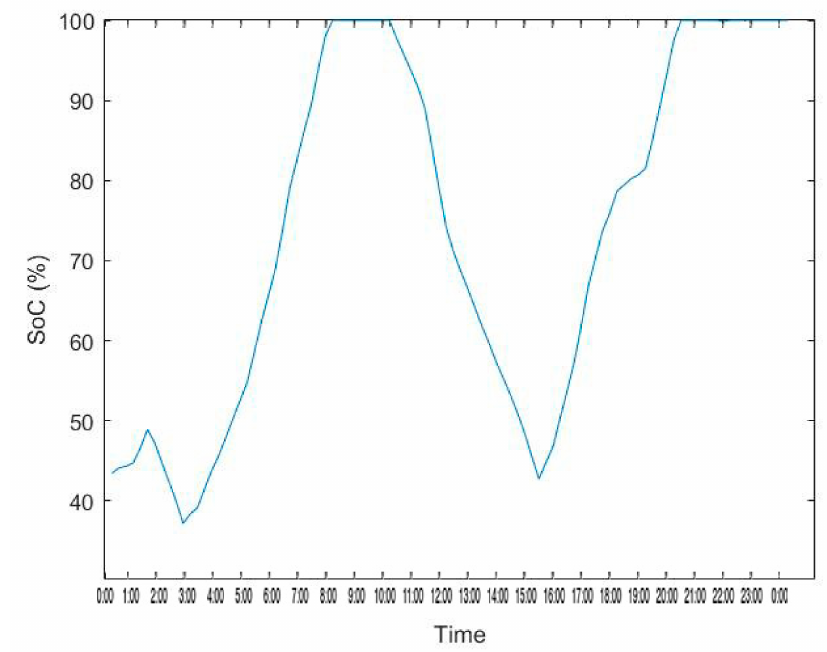
Figure 15. State of charge of Street Battery in Faulty